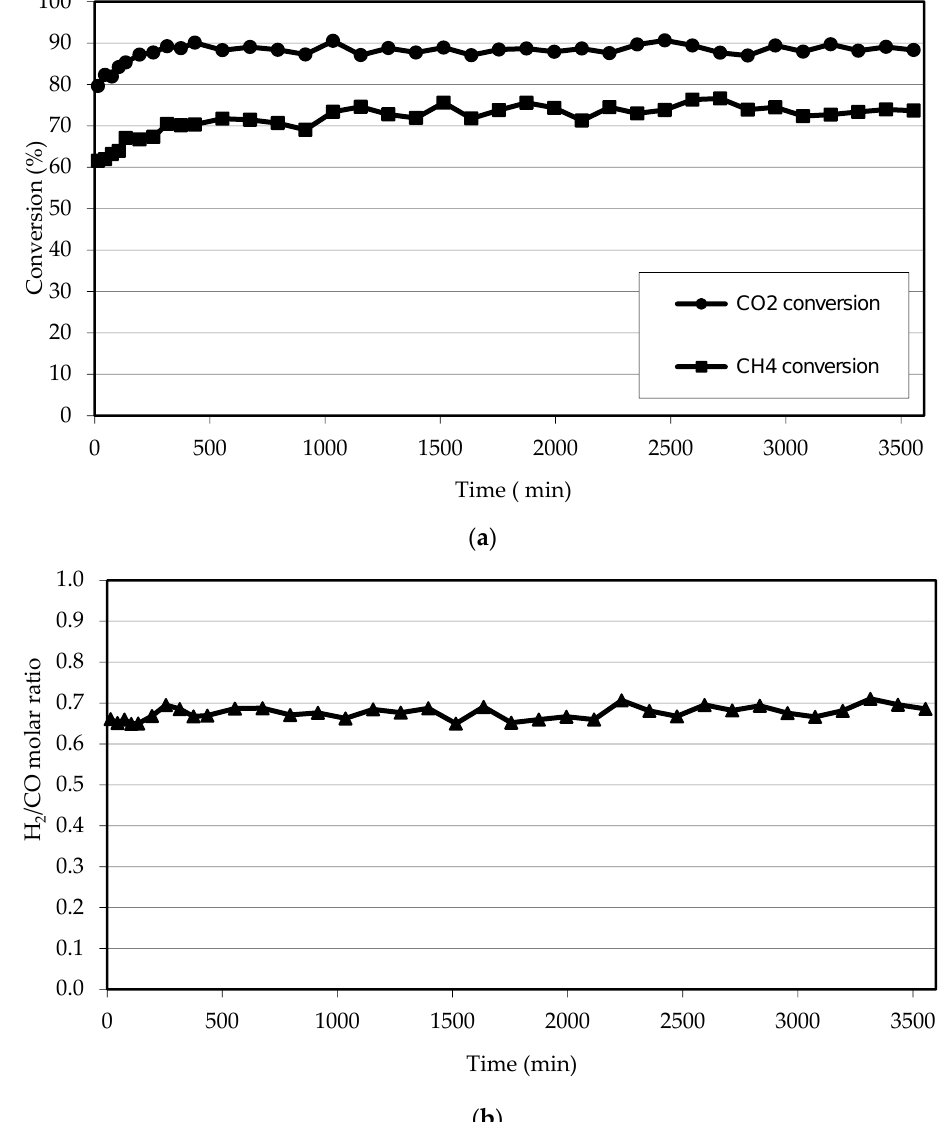
Figure 8. CO 2 and CH 4 conversions ( a ) and H 2 /CO molar ratios ( b ) vs. reaction time for Ru(1 wt%)/Al 2 O 3 -K(10 wt%) catalyst tested during 59 in the dry reforming reaction at 750 °C.